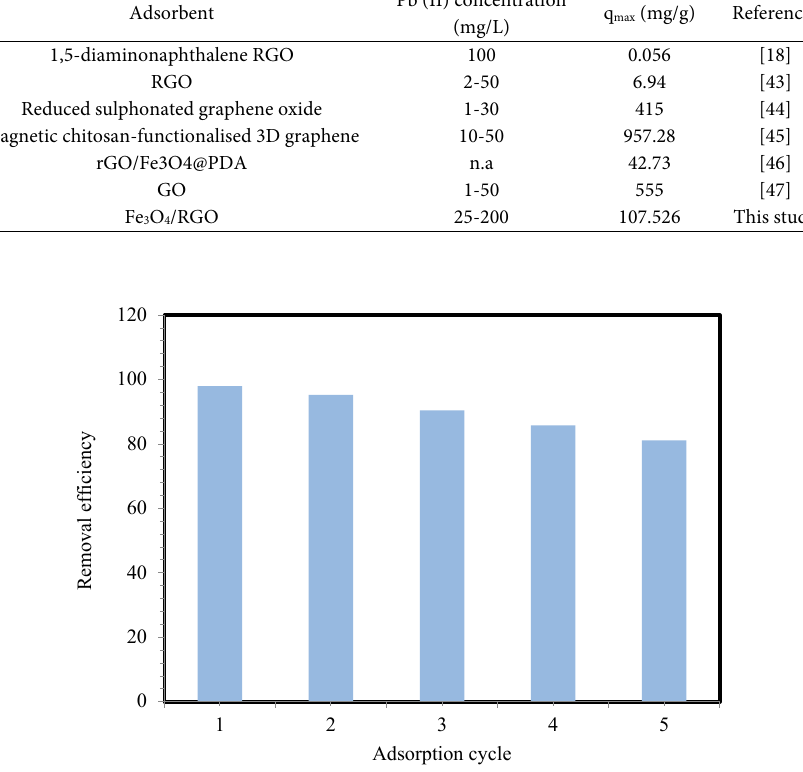
Fig. 12. Reuse experiment for Fe